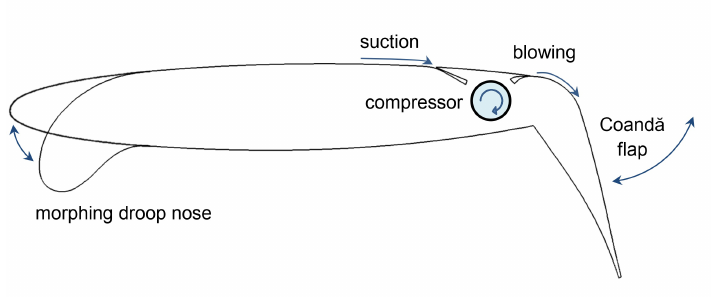
Figure 2. Wing profile showing morphing leading edge and actively-blown Coand˘a